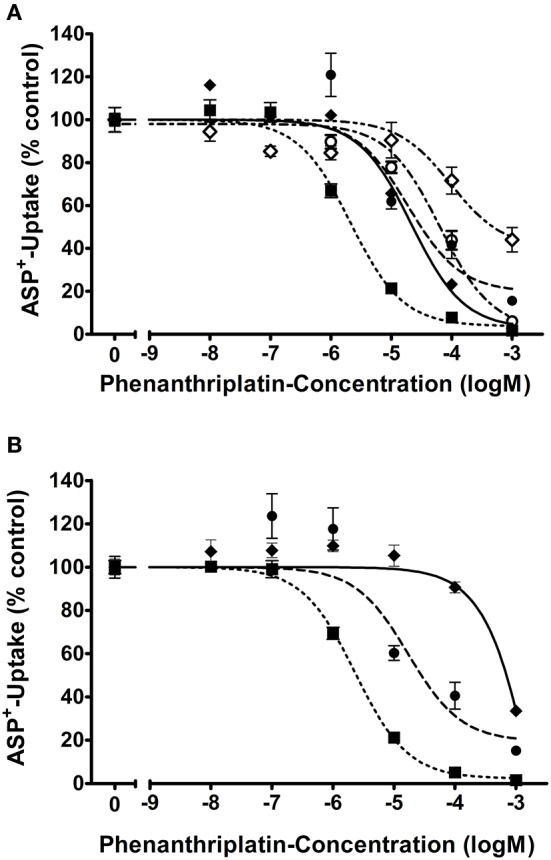
Apparent affinities (IC50) of (A) hOCT1 (; n = 6–12), hOCT2 (; n = 6–12), hOCT3 (; n = 6–12), hMATE2K (; n = 15–16), and hMATE1 (; n = 7–24) and (B) mOCT1 (; n = 6–11), mOCT2 (; n = 6–12), mOCT3 (; n = 6–10) for phenanthriplatin. Values are means ± SEM expressed as % of ASP+-uptake in the absence of phenanthriplatin, which was set to 100% (control). The IC50 values for the inhibition of initial ASP+ uptake by phenanthriplatin were 19, 2, 21, 101, and 57 μM for hOCT1, hOCT2, hOCT3, hMATE1, and hMATE2K, respectively. Those for mOCT1, mOCT2, and mOCT3, were 17, 2, and 3,146 μM, respectively.